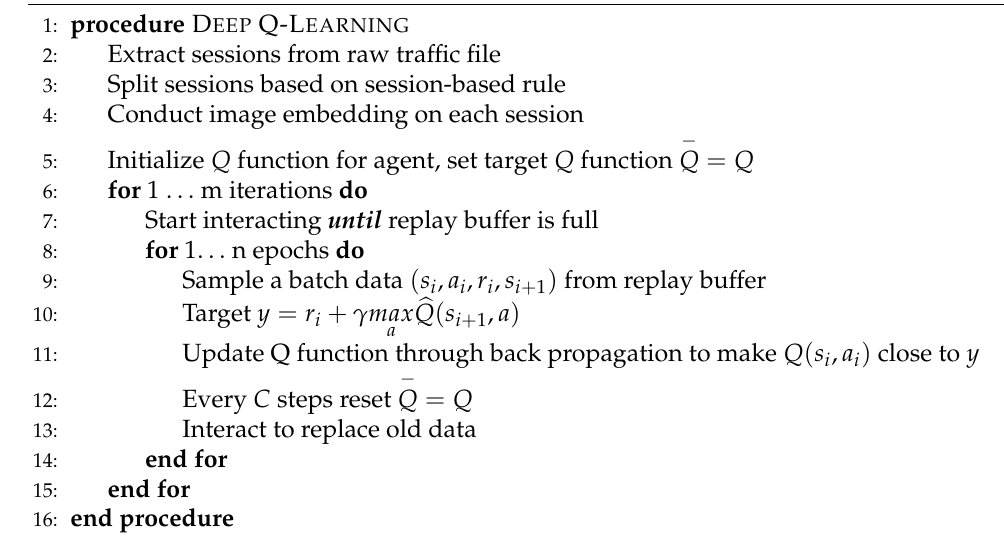
Algorithm 2 Deep Q-Learning Framework for Detection at